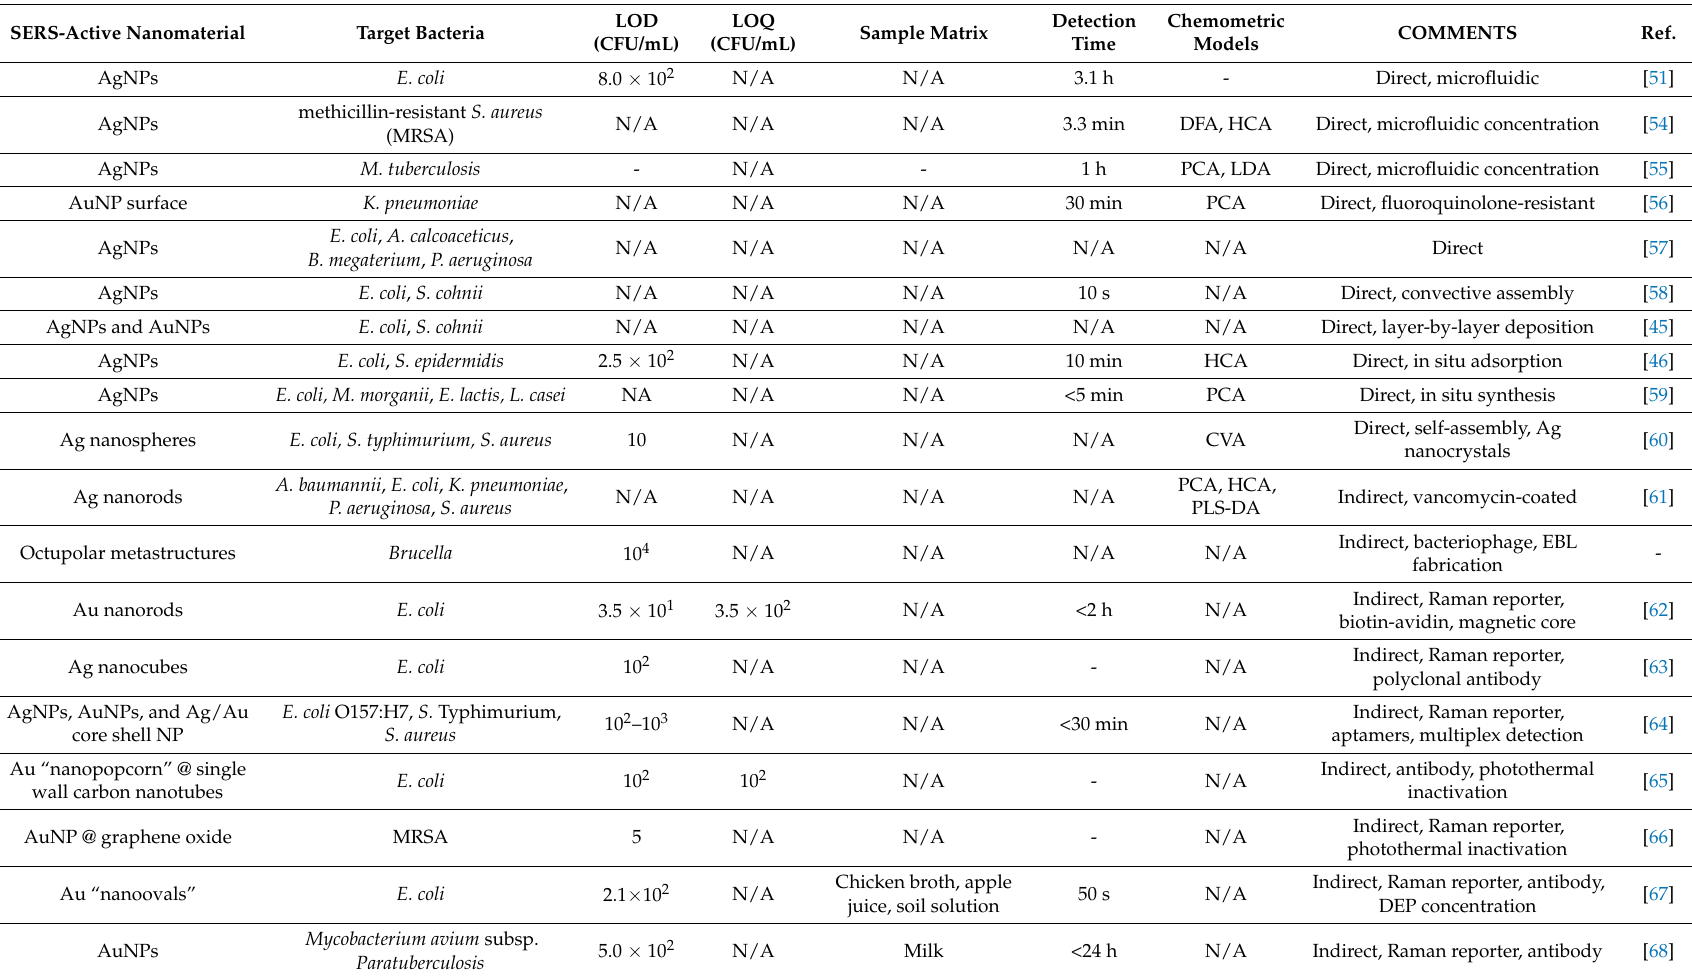
Table 1. Summary of SERS-active nanomaterials used for the detection of